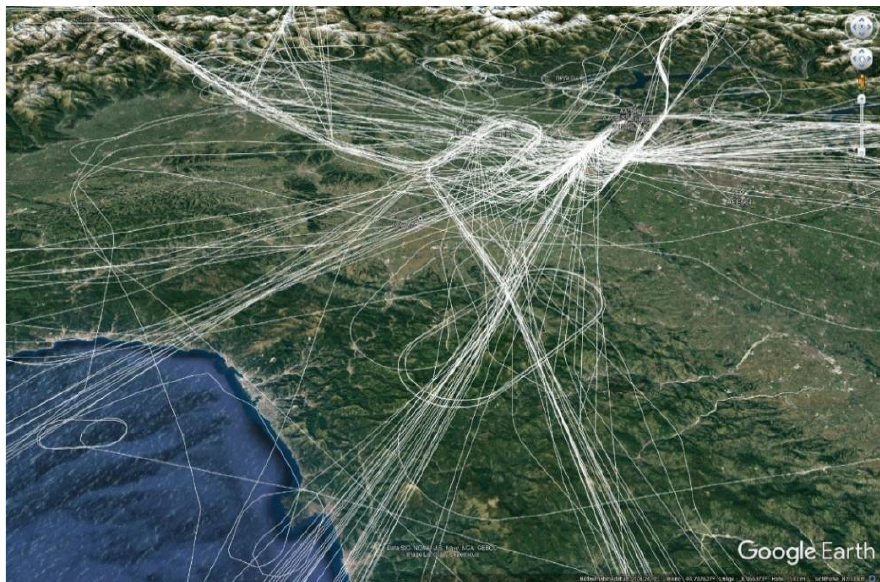
Figure 14. Prepared FlightRadar24 datasets from 11 May 2019 with flights operated under adverse weather conditions.